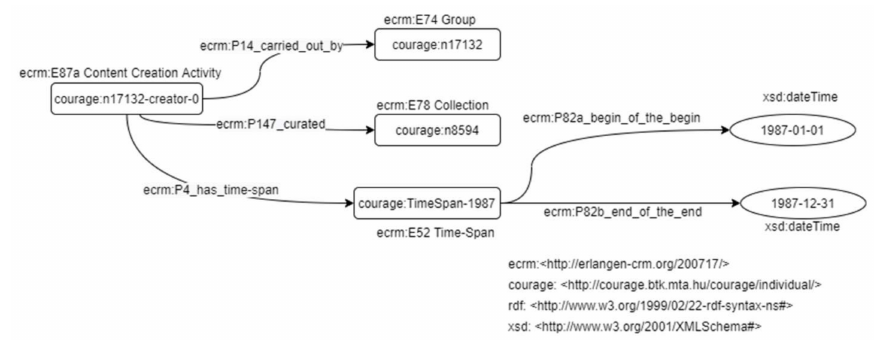
Figure 11. Creator role representation in